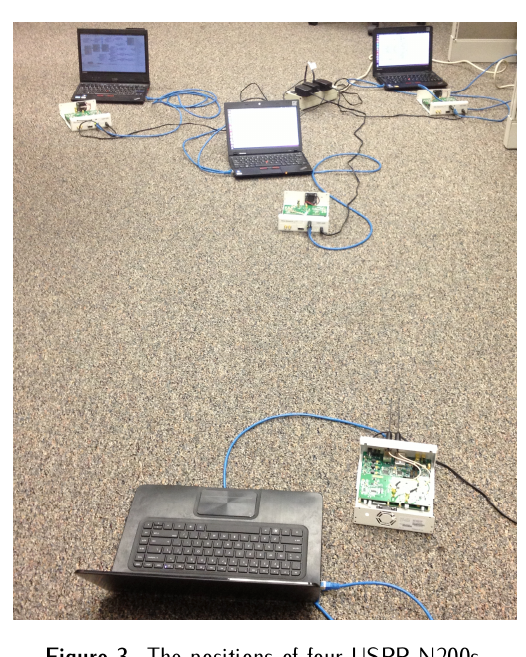
Figure 3. The positions of four USRP N200s.